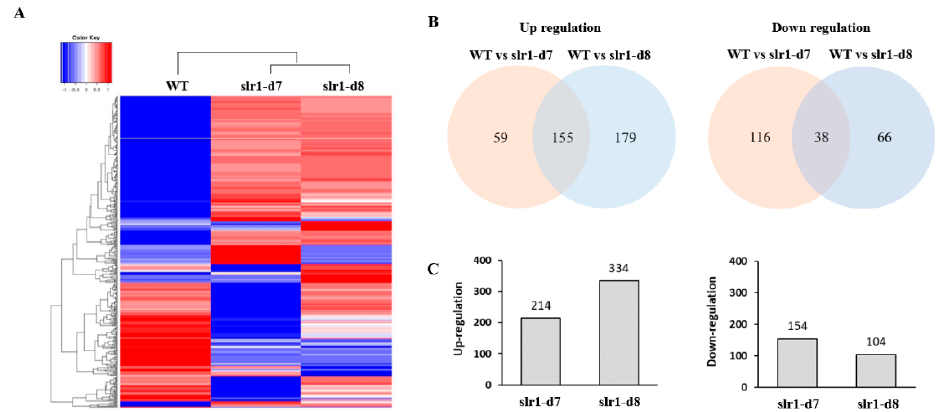
Figure 3. Global gene expression changes in knockout OsSLR1 in rice. ( A ) Heat map of gene expression between WT vs. slr1-d7 and WT vs. slr1-d8 lines. Red denotes samples with relatively high expression of a given gene and blue denotes samples with relatively low expression. ( B ) Comparison of the number of differentially expressed genes (DEGs) in WT vs. slr1-d7 and WT vs. slr1-d8. ( C ) The number of DEGs up- and down-regulated between WT vs. mutant lines.